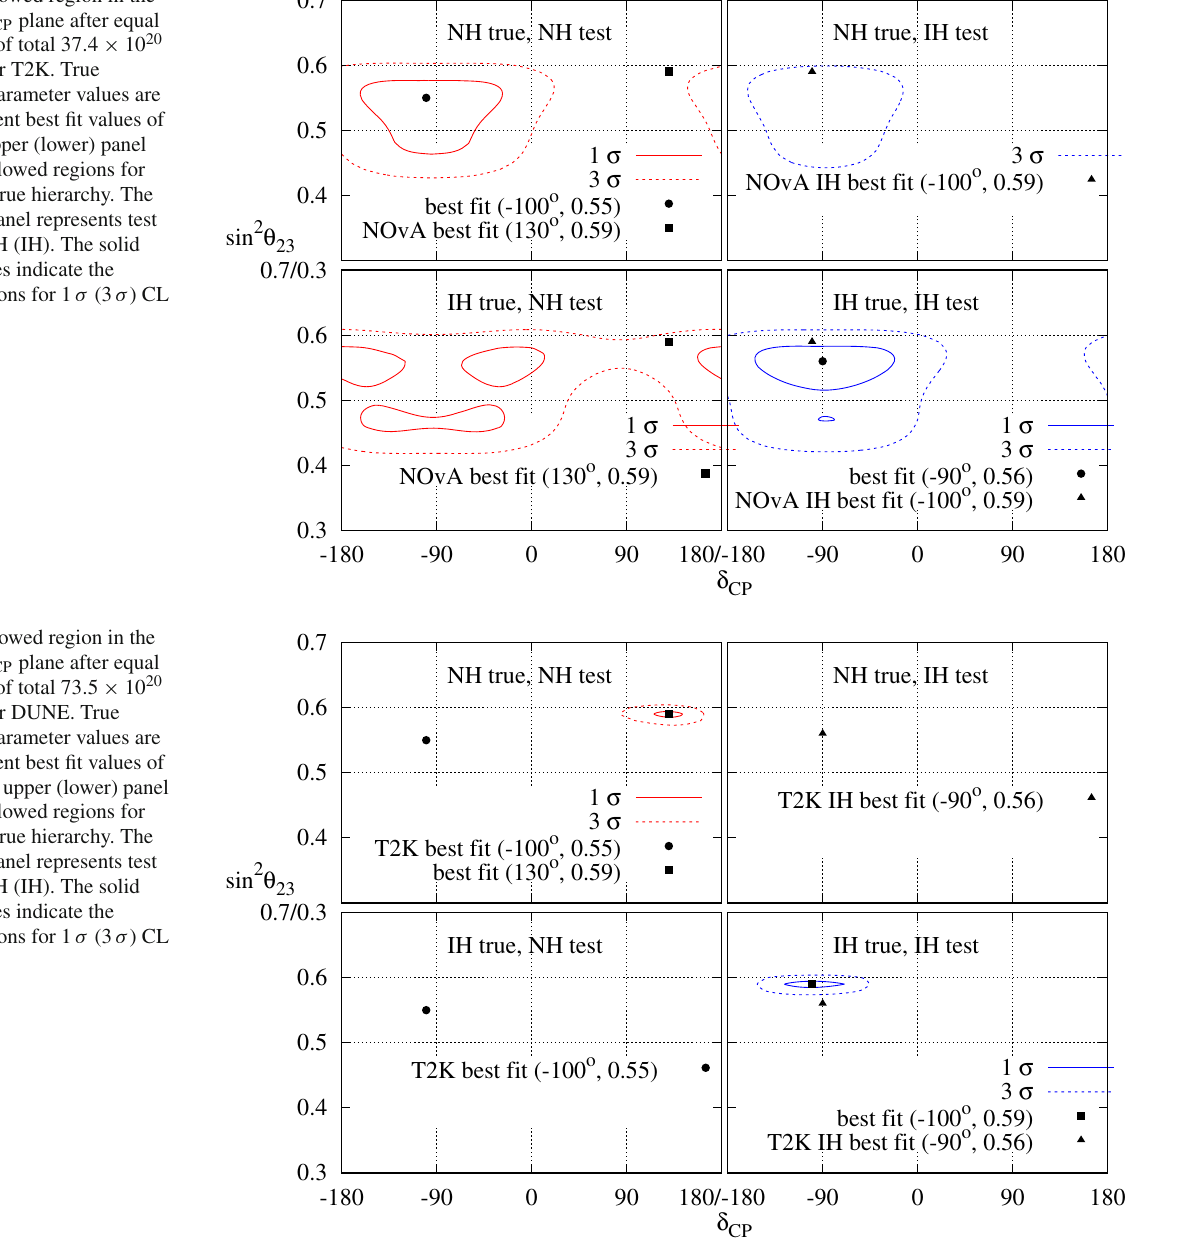
Fig. 11 Allowed region in the sin 2 θ 23 − δ CP plane after equal ν and ¯ ν run of total 37 . 4 × 10 20 POT each for T2K. True oscillation parameter values are fixed at current best fit values of T2K. The upper (lower) panel shows the allowed regions for NH (IH) as true hierarchy. The left (right) panel represents test hierarchy NH (IH). The solid (dashed) lines indicate the allowed regions for 1 σ (3 σ ) CL